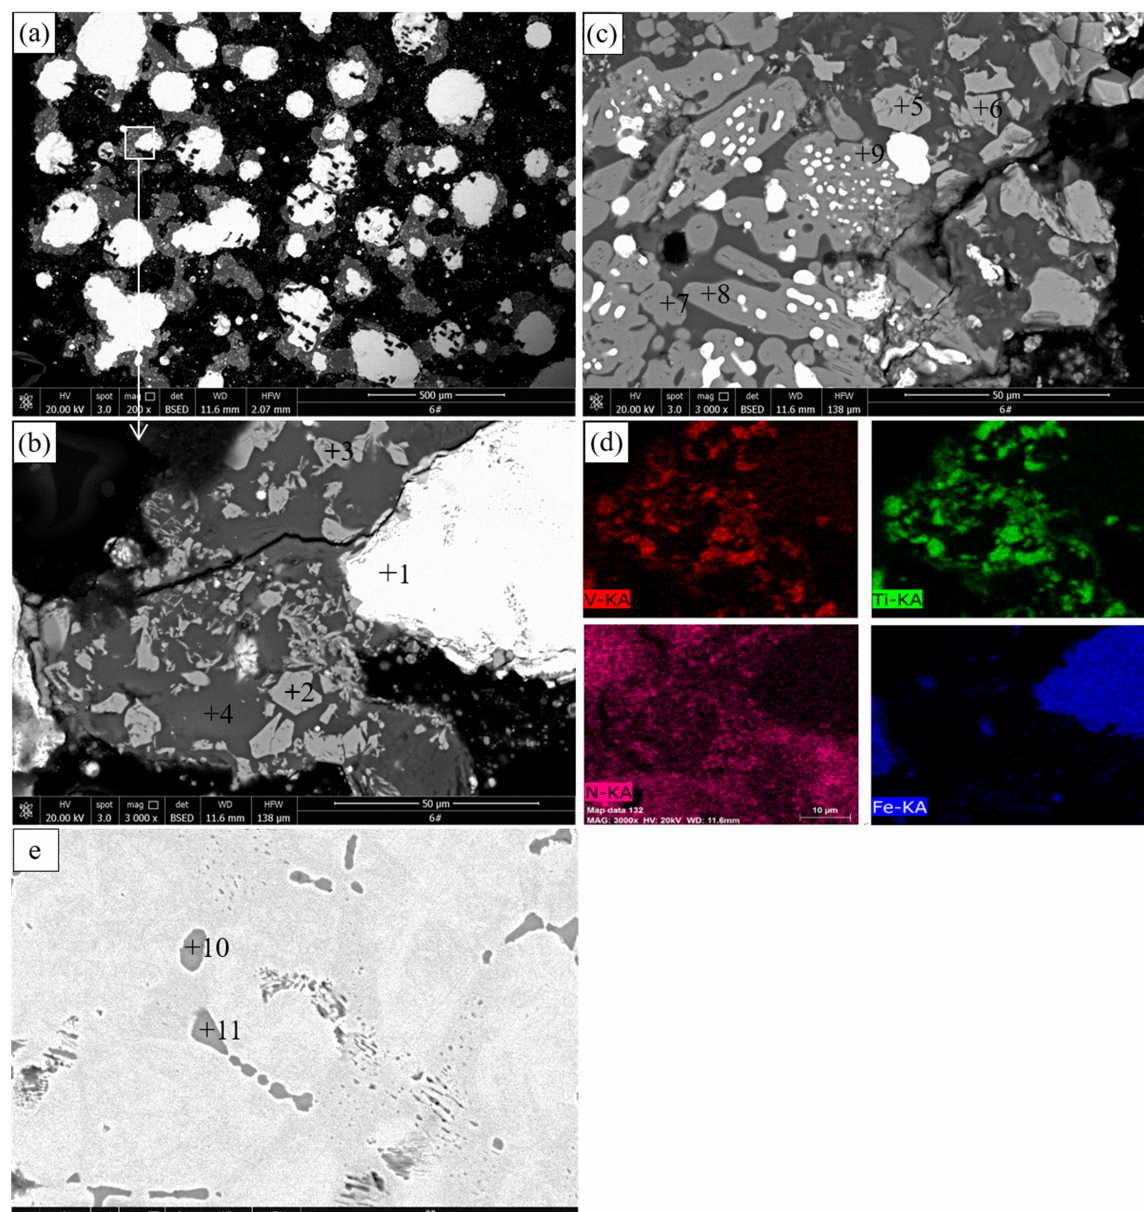
Figure 7. Microstructure and EDS results of the pellets roasted at 1300 ◦ C for 90 min: ( a ) typical SEM image; ( b ) the reduced titanomagnetite; ( c ) the reduced ilmenite; ( d ) V, Ti, N, and Fe elemental maps of the area shown in ( b ); ( e ) metallic